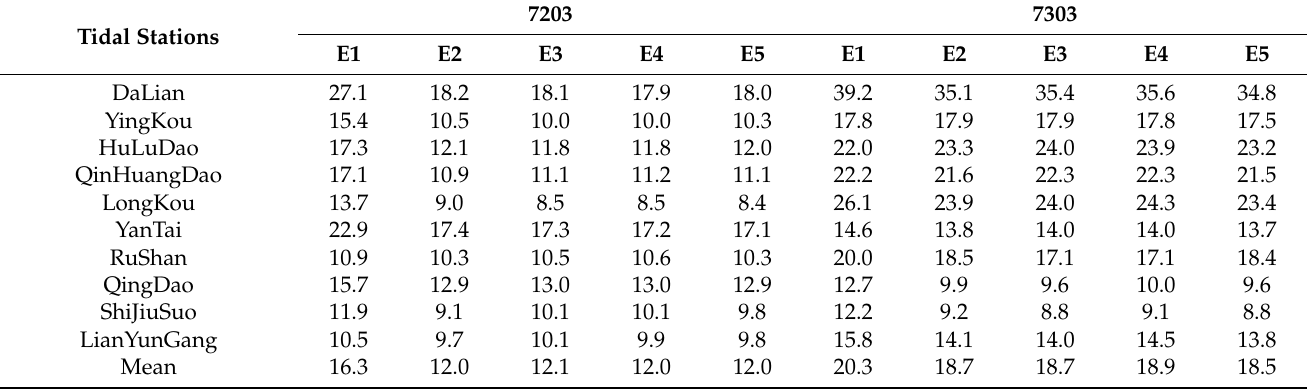
Table 5. Root–mean–square errors between simulated and observed storm surge levels at 10 tidal stations during Typhoons 7203 and 7303 (unit: